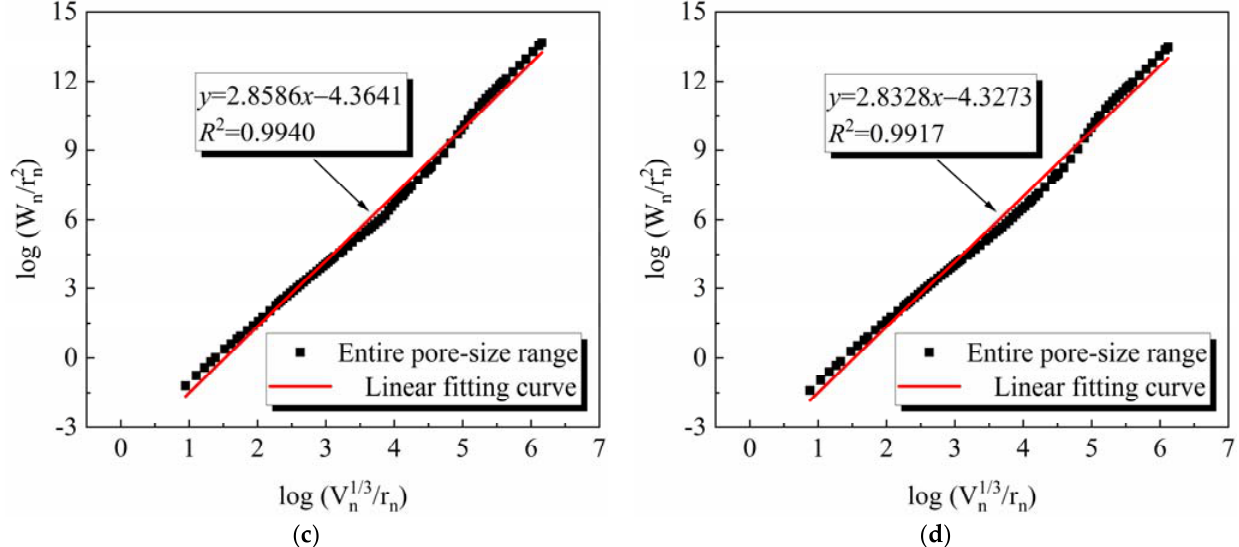
Figure 10. Fractal properties of pore structure in ECC with different fine aggregates. ( a ) DSN-ECC. ( b ) DSY-ECC. ( c ) RS-ECC. ( d ) SS-ECC. Table 7. The D values of ECC with different fine aggregates. Mixtures